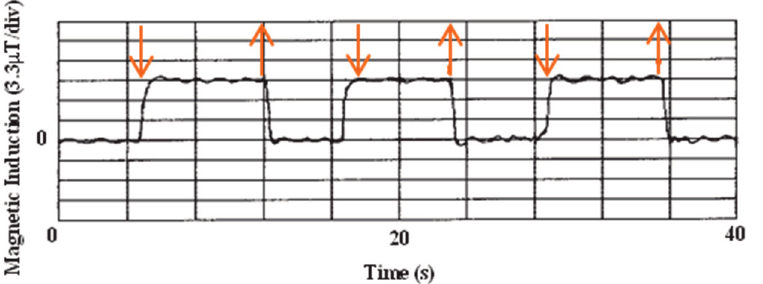
Figure 2. Real time variation of the magnetic induction on the InSb micro-Hall sensor due to the presence of a single micro-bead as measured by monitoring changes in Hall voltage after the application (downward arrow) and removal (upward arrow) of the 320 Oe by magnet. The ac in-plane field was 44 Oe at 670 Hz and lock-in time constant was 100 ms. Adapted from